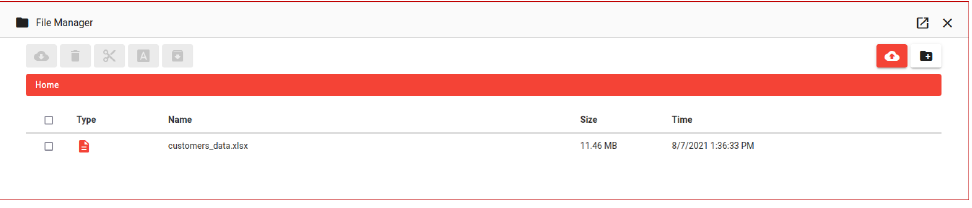
Figure 13. Herd-View File